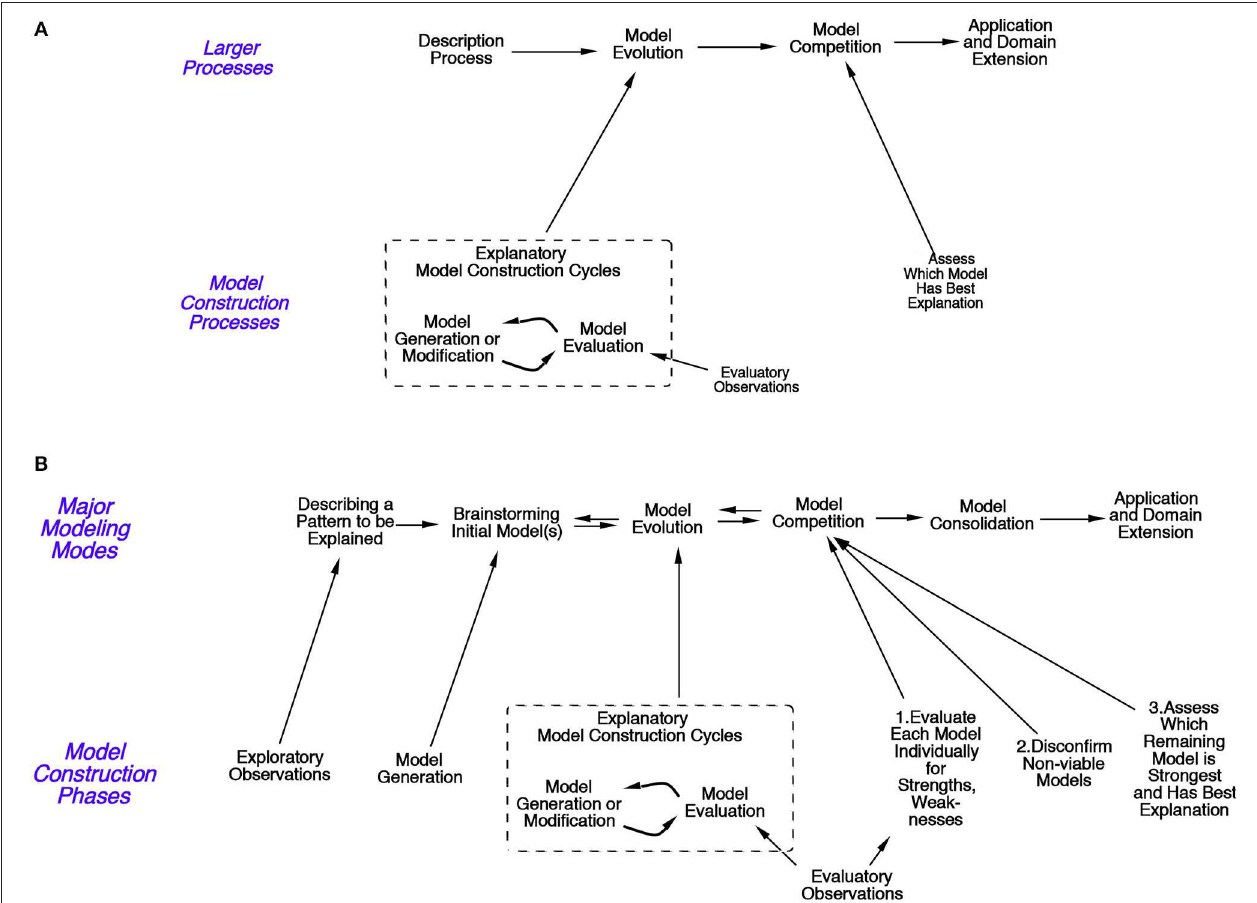
FIGURE 4 | (A) Initial modeling practices framework from expert study showing two nested levels of processes. (B) Modeling practices framework for classrooms showing two nested levels of processes (Phases in lower level of (B) are shown here only for the first four Modes in the upper level. See transcript analysis for others).